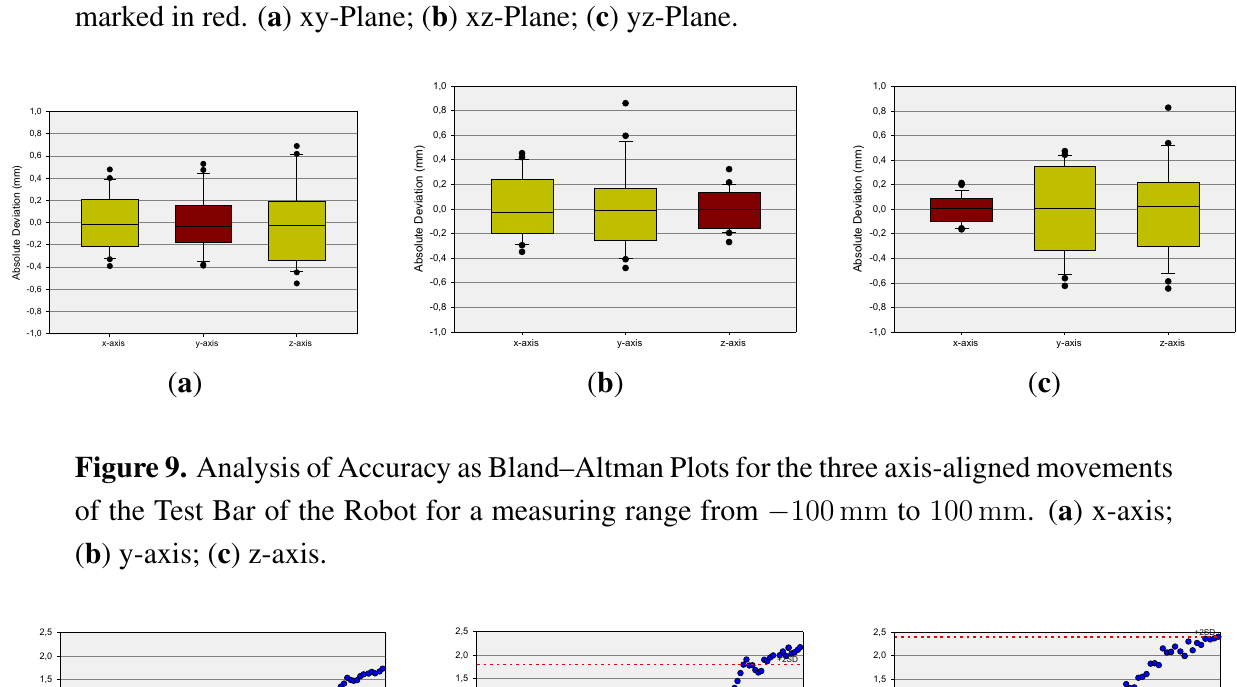
Figure 8. Analysis of Accuracy of the Measured Positions. The fixed Orientations are marked in red. ( a ) xy-Plane; ( b ) xz-Plane; ( c ) yz-Plane.